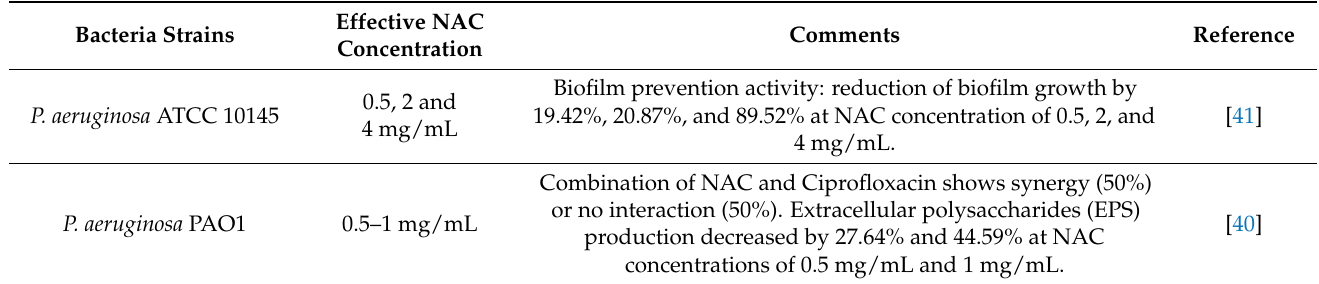
Table 1. Examples of in vitro NAC activity against